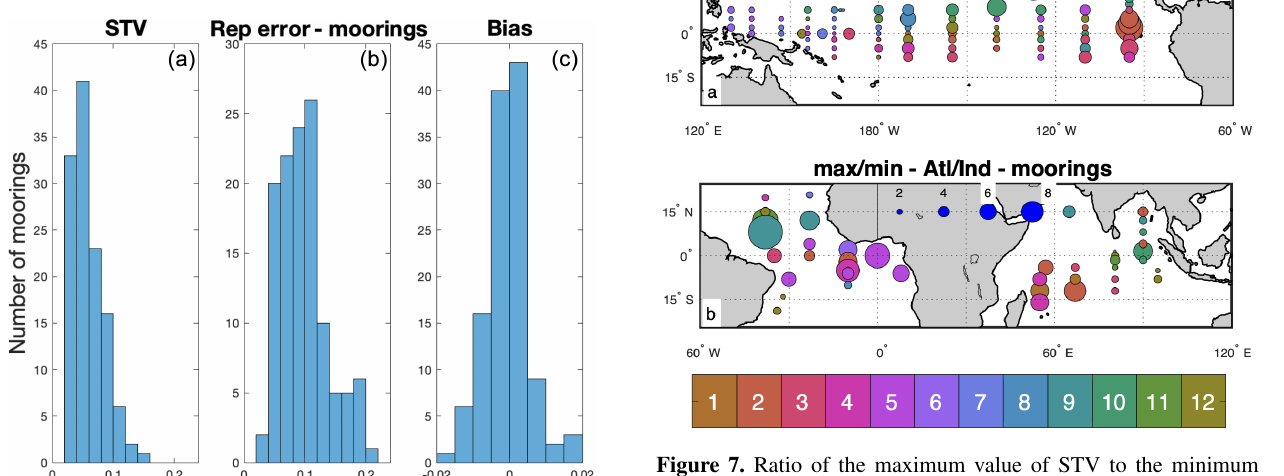
Figure 7. Ratio of the maximum value of STV to the minimum value (sizes of symbols), and the month of the maximum STV (symbol colors with scale at bottom in months, January–December). Panel (a) shows the Pacific Basin, and panel (b) shows the Atlantic and Indian basins. A size scale for the STV ratio is shown as blue circles near the middle of each